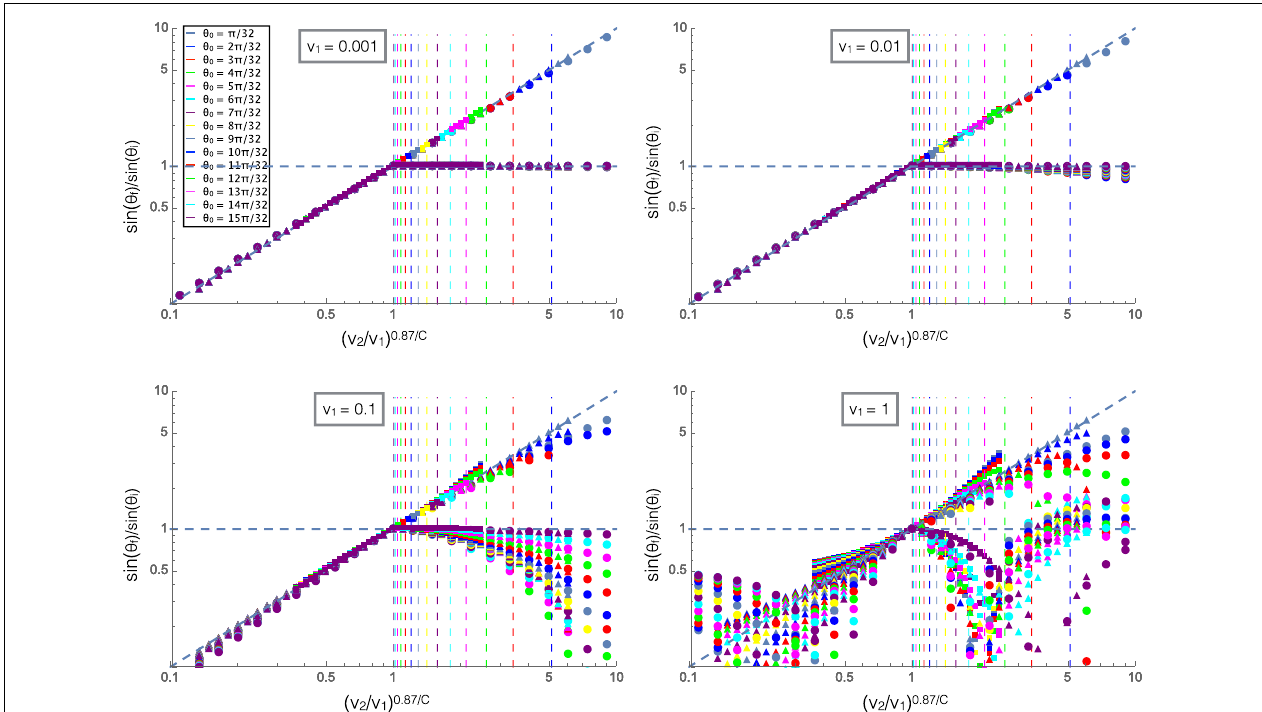
FIGURE 5 | The ratios of the sines of the initial and final trajectory angles measured with respect to the normal to the interface . The velocity on the top substrate ( v 1 ) is labeled for each plot and the color legend for incident angle is consistent across all four plots. Squares are for C = 2, triangles for C = 1, and circles for C = 0.5. The diagonal line is a fit for the low velocity case and the vertical lines are predicted values for the reflections to begin for each incident angle shown by color according to the legend.